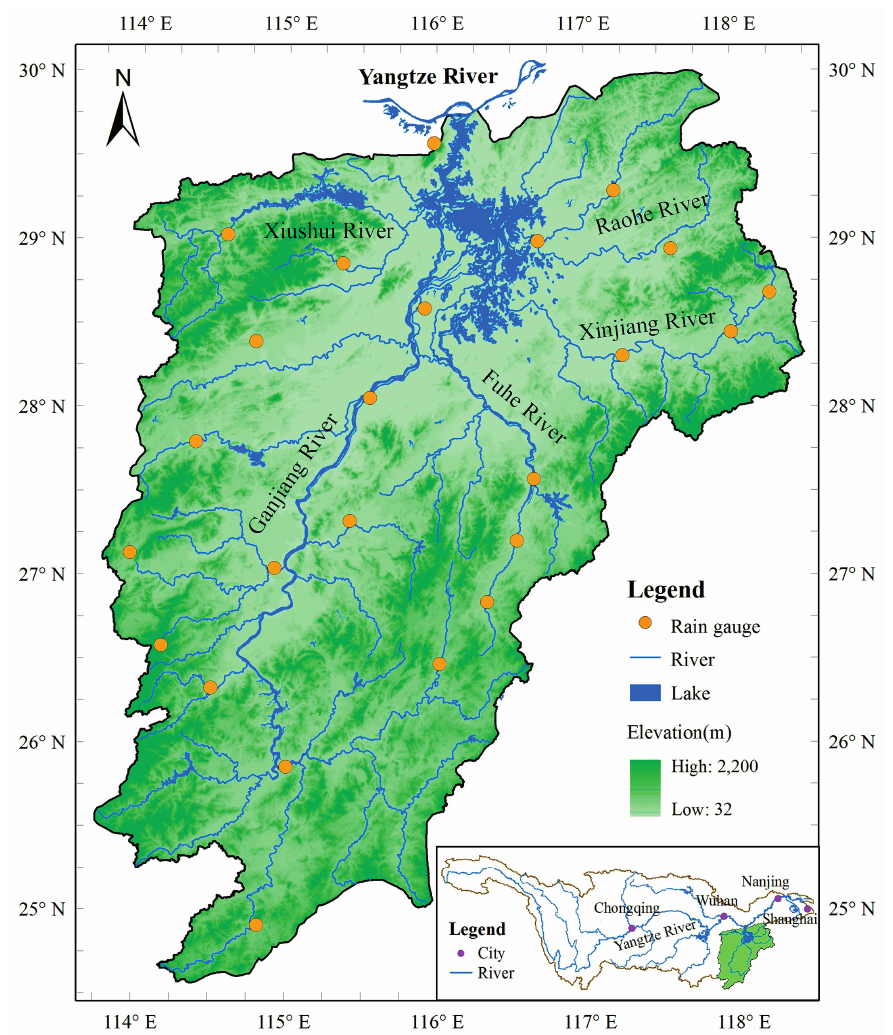
Figure 1. Location of the study area and the distribution of